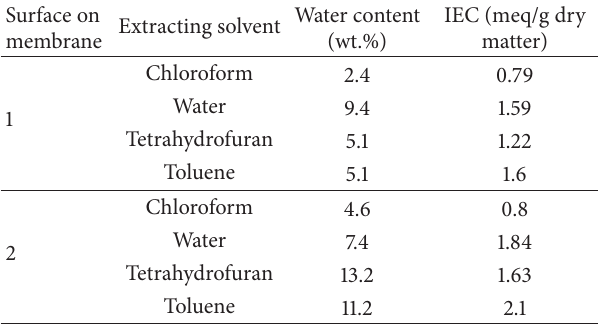
Table 3: The results of water content and IEC of anion-exchange hybrid PES